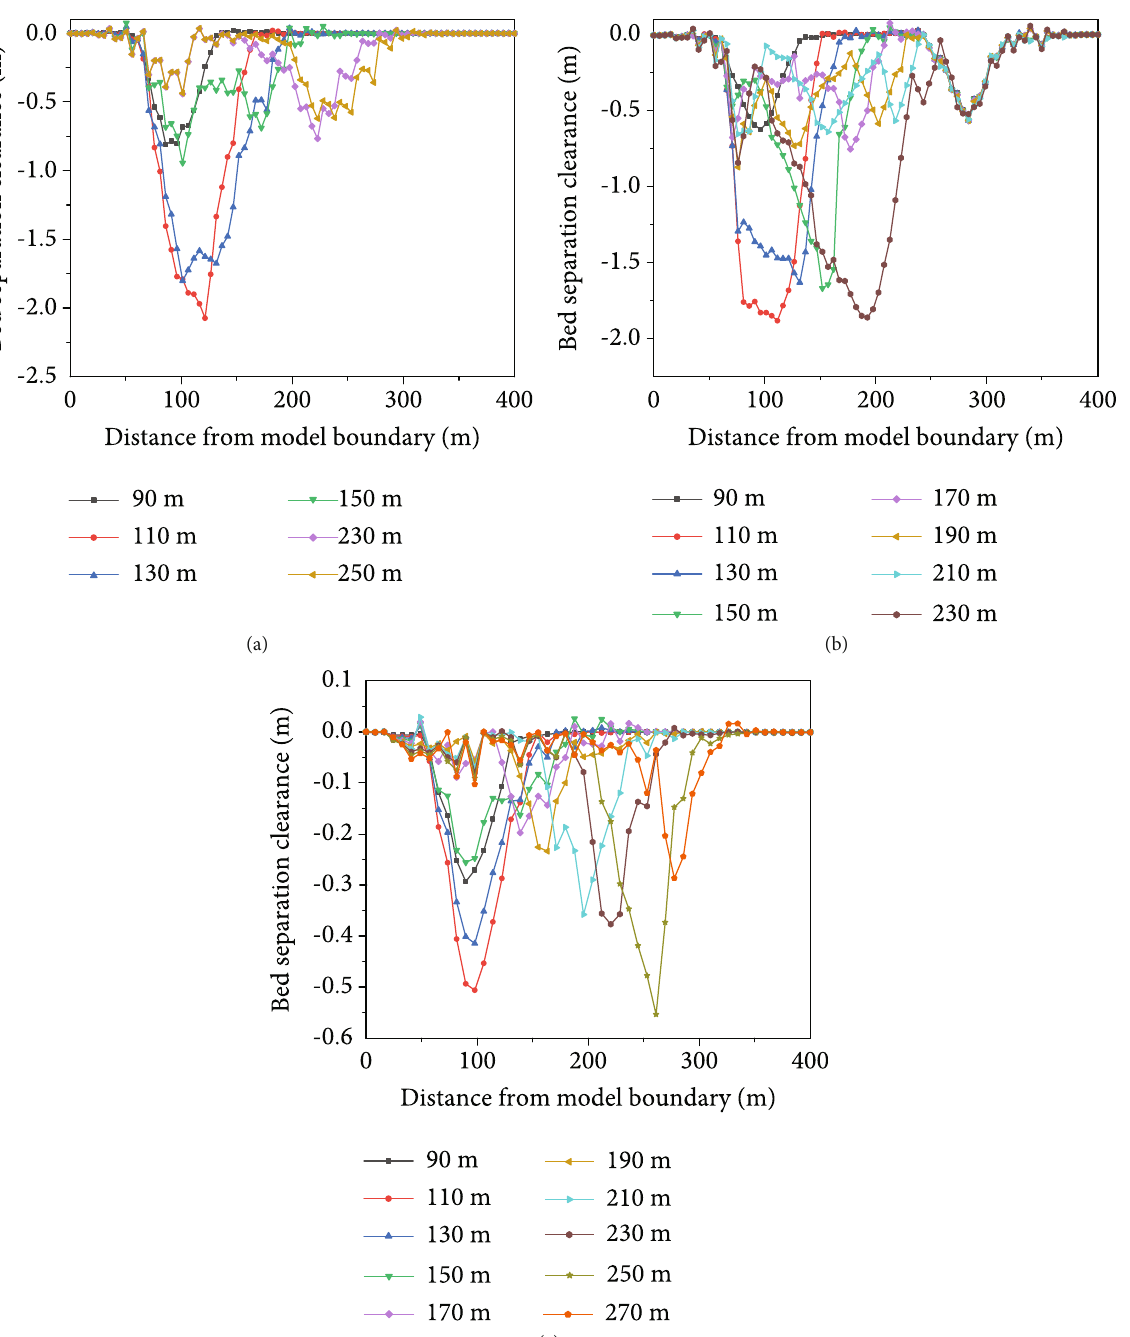
Figure 9: Variation pattern of bed separation clearance ((a) – (c) are the bed separation interval when mining coal 1, coal 2, and coal 3,